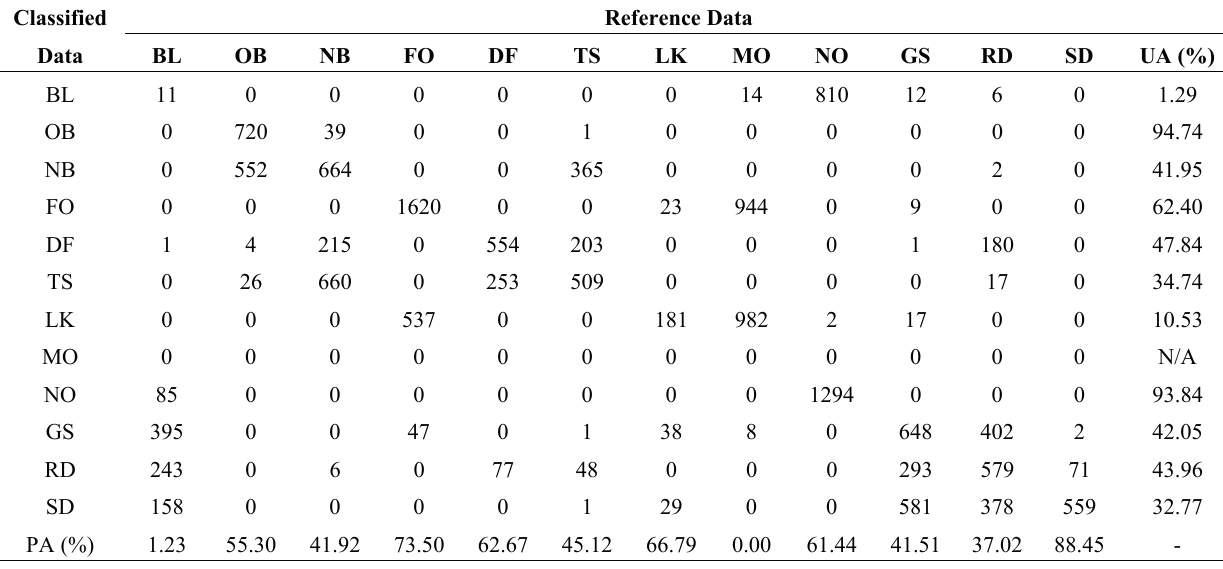
Table 5. Confusion Matrix of the Wishart Supervised Classification